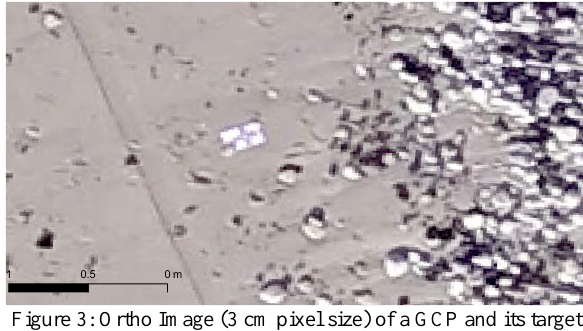
Figure 3: Ortho Image (3 cm pixel size) of a GCP and its target paper.